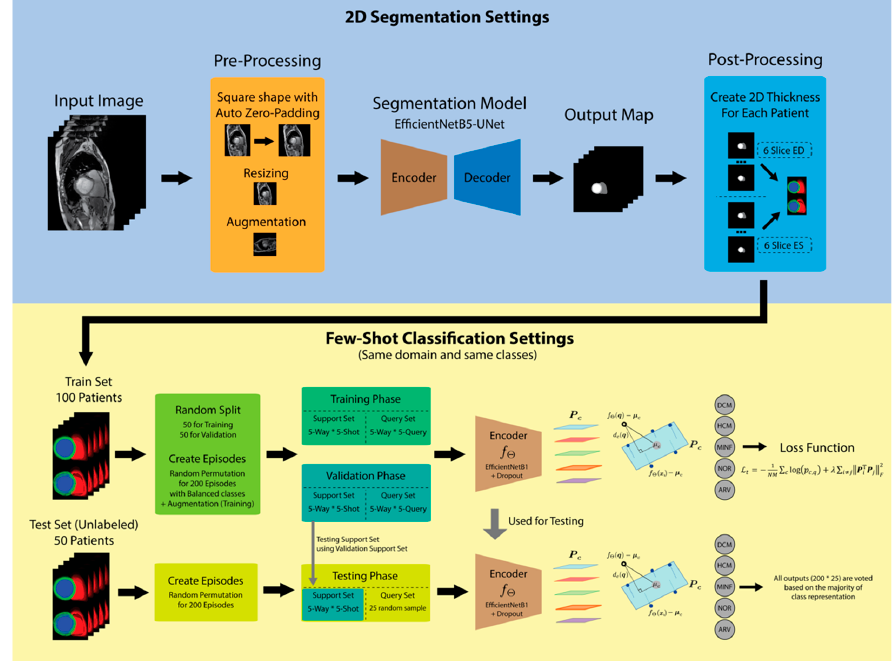
Figure 1. Proposed architecture consisting of 2D segmentation ( top ) and few-shot classification ( bottom ).